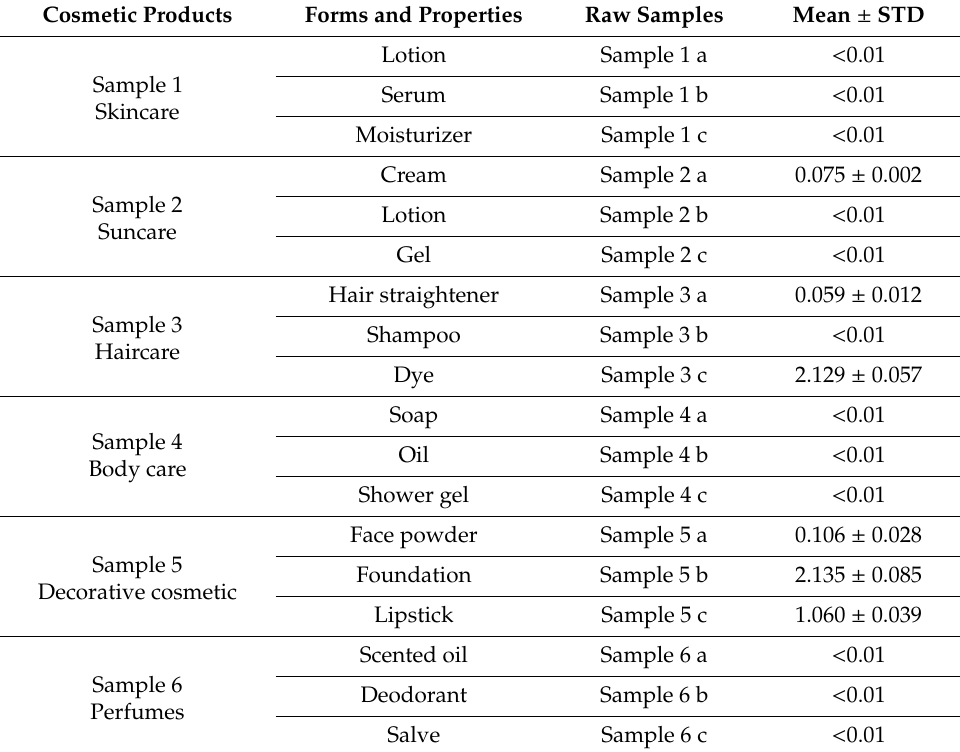
Table 3. Determination of mercury concentration in cosmetic samples.